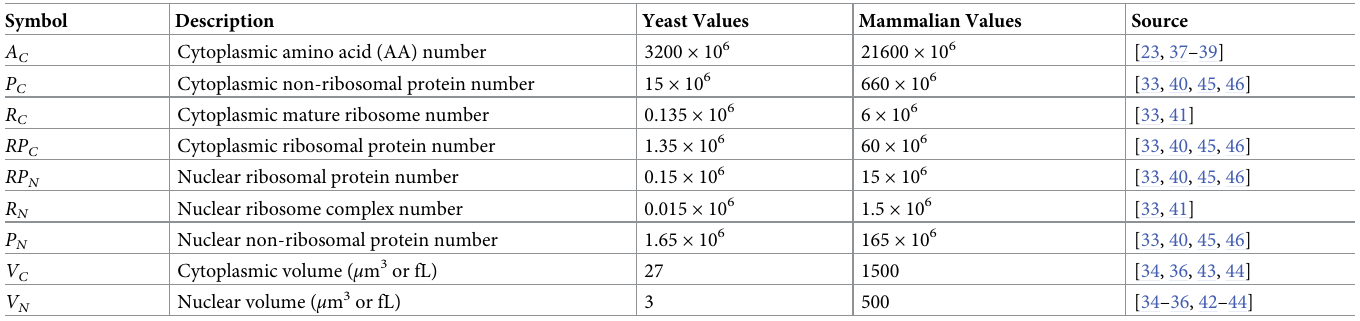
Table 1. Glossary of model variables and their numerical estimates for new born cells. See text for references. Symbol